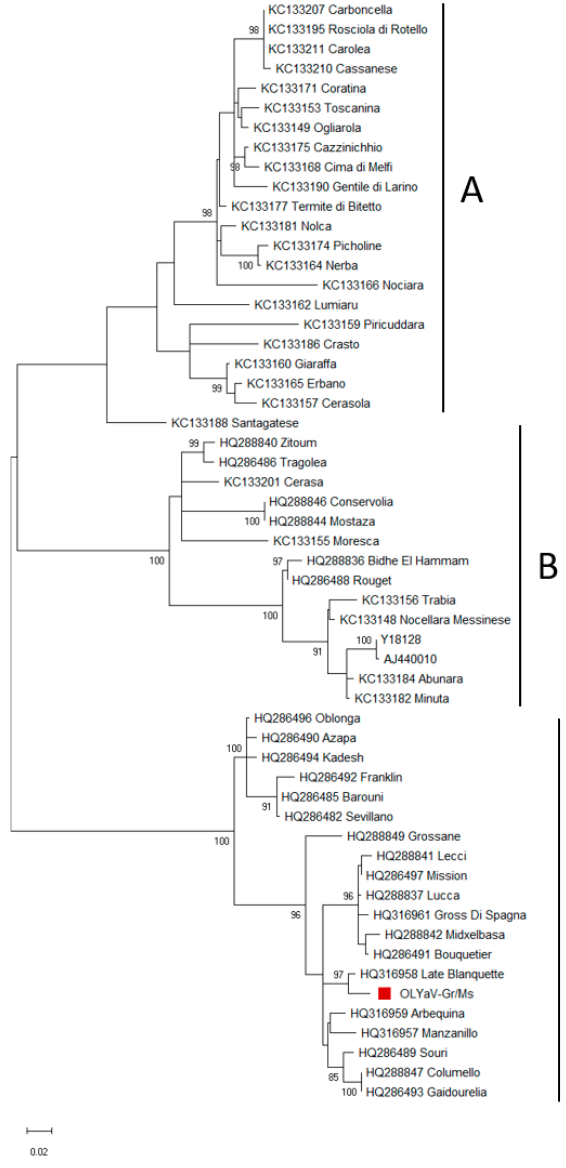
Figure 2. Evolutionary analyses conducted by MEGA X using nucleotide sequences of the OLYaV HSP70h gene. The analysis involved 56 nucleotide sequences. There was a total of 353 positions in the final dataset. The available OLYaV sequences originating from Italian and American germplasm collections (cultivars from different countries) are reported with their accession numbers and cultivar name, whereas the Greek isolate determined in this study is indicated by a red square and its designated name. Branches with <85% bootstrap support were collapsed. The scale bar represents a genetic distance of